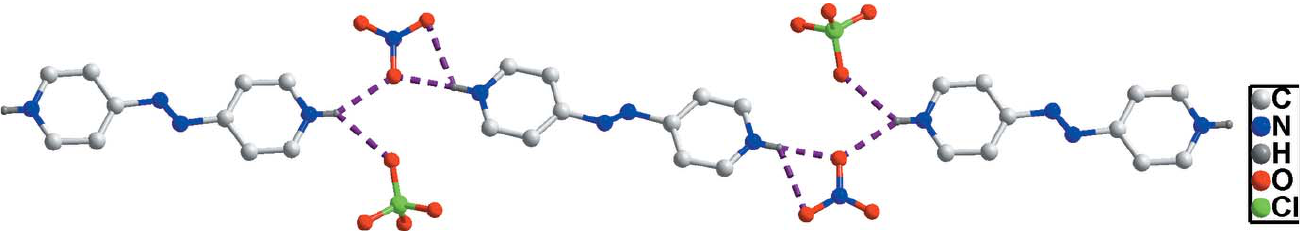
Figure 2 Chain in the structure of the title compound formed by N—H (cid:2)(cid:2)(cid:2) O hydrogen bonds (shown as dashed lines). Hydrogen atoms not involved in hydrogen bonding are omitted.